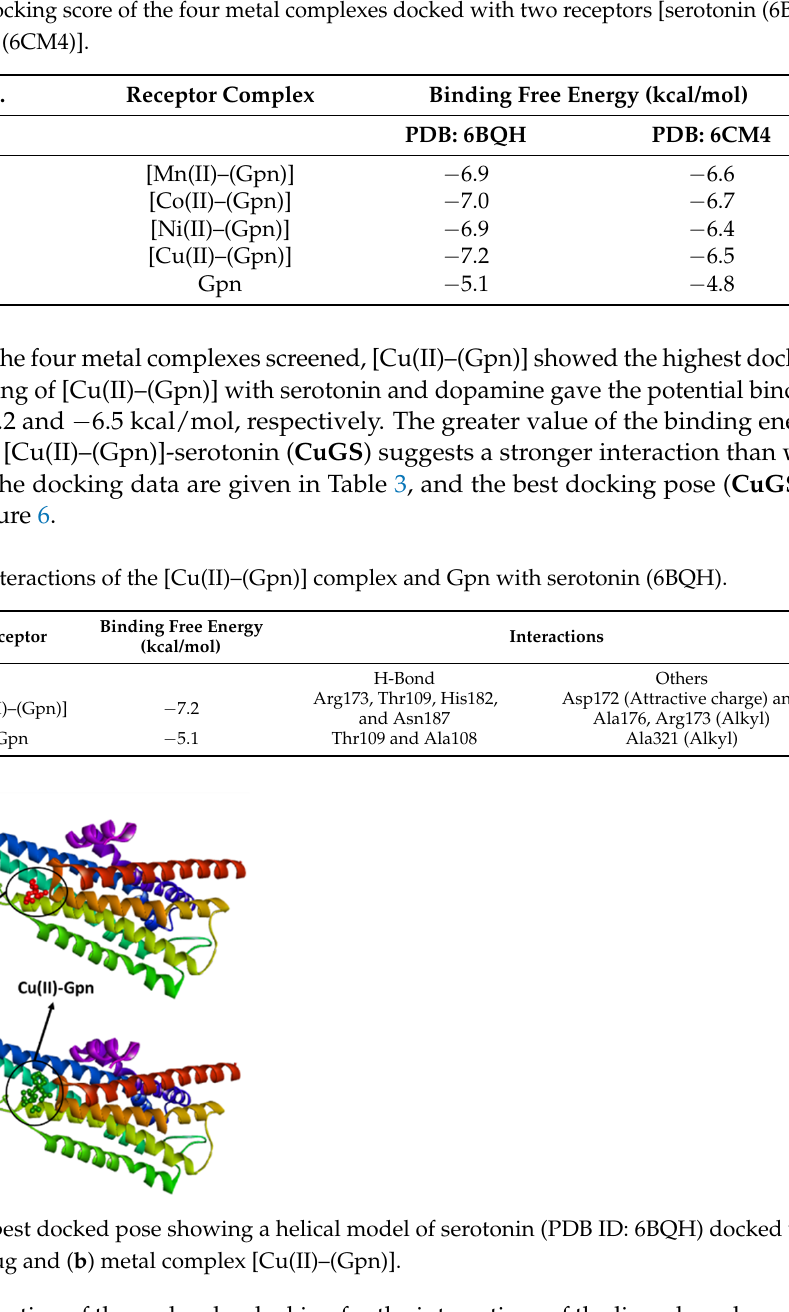
Figure 7. The 3D representation of the interactions for serotonin (PDB ID: 6BQH) docked with ( a ) the Gpn drug and ( b ) metal complex [Cu(II)–(Gpn)]. As shown in Figure 8a, CuGS showed that the residues Arg173, Thr109, His182, and Asn187 had established hydrogen bonds. Additionally, Asp172 (Attractive charge) and Ala176 and Arg173 (Alkyl) interactions could also be seen [40,41]. Similarly, docking of the Gpn drug with serotonin and dopamine gave the potential binding energy of −5.1 and −4.8 kcal/mol, respectively. The greater value of the binding energy in the case of Gpn- serotonin ( GpnS ) suggests a stronger interaction than that with dopamine. Figure 8b shows the interaction between Gpn and serotonin, revealing that the residues Thr109 and Ala108 had established hydrogen bonds. Additionally, Ala321 showed alkyl interactions. These findings suggest that the metal [Cu(II)–(Gpn)] binds with the receptors more effi- ciently than the Gpn drug. The 2D representations of the interactions between the metal complex/drug and receptor are shown in Figure 8. The other binding details of the inter- actions are tabularized in Tables 4 and 5.